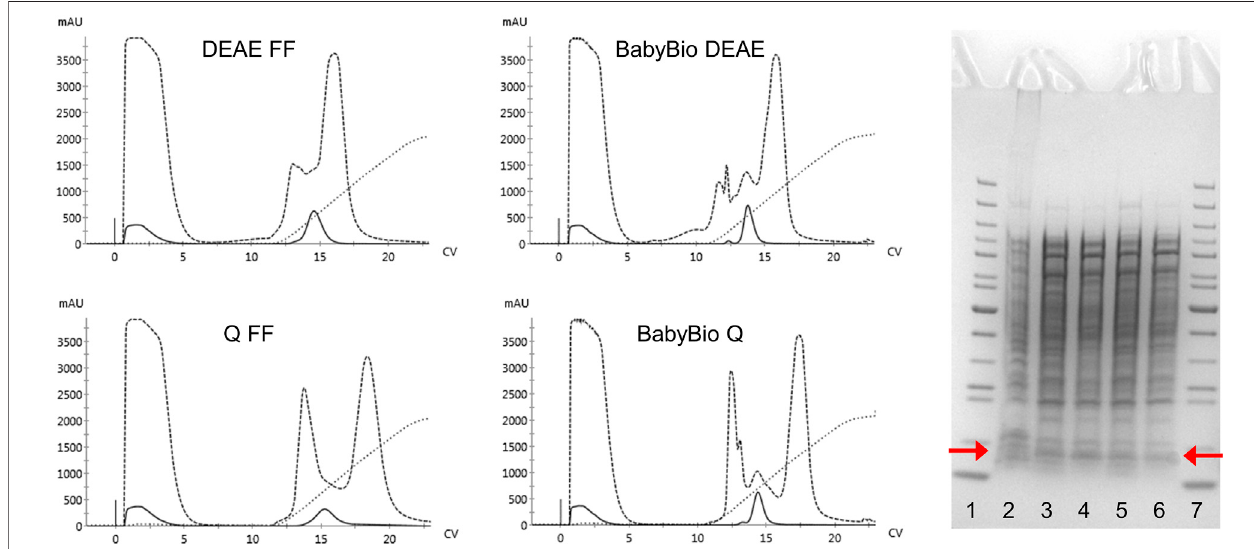
FIGURE 3 | Four chromatograms display the puri fi cation procedures on rHbF α 4/ γ 2 from E. coli crude extracts in 1 ml columns of different anion exchange resins (HiTrap DEAE FF and Q FF (GE Healthcare) and BabyBio DEAE and Q (Bio-Works)). Solid lines indicate the 419 nm UV trace, dashed lines indicate 280 nm, and dotted linesshowthe increase in conductivity during elution. Thecolumns wereequilibrated with20 mM Tris-HCl buffer pH 8.0and elutionwasperformed with aNaCl gradient up to 1 M. The SDS-PAGE gel to the right of the chromatograms shows the protein crude extract and the collected Hb-containing fractions after the chromatographic runs (red arrows indicate the location of the Hb monomer band). The wells contain: 1) PageRuler ™ Unstained Protein Ladder (ThermoFisher), 2) rHbF α 4/ γ 2 crude extract, 3) BabyBio DEAE elution, 4) BabyBio Q elution, 5) DEAE FF elution, 6) Q FF elution, 7) PageRuler ™ Unstained Protein Ladder (ThermoFisher).